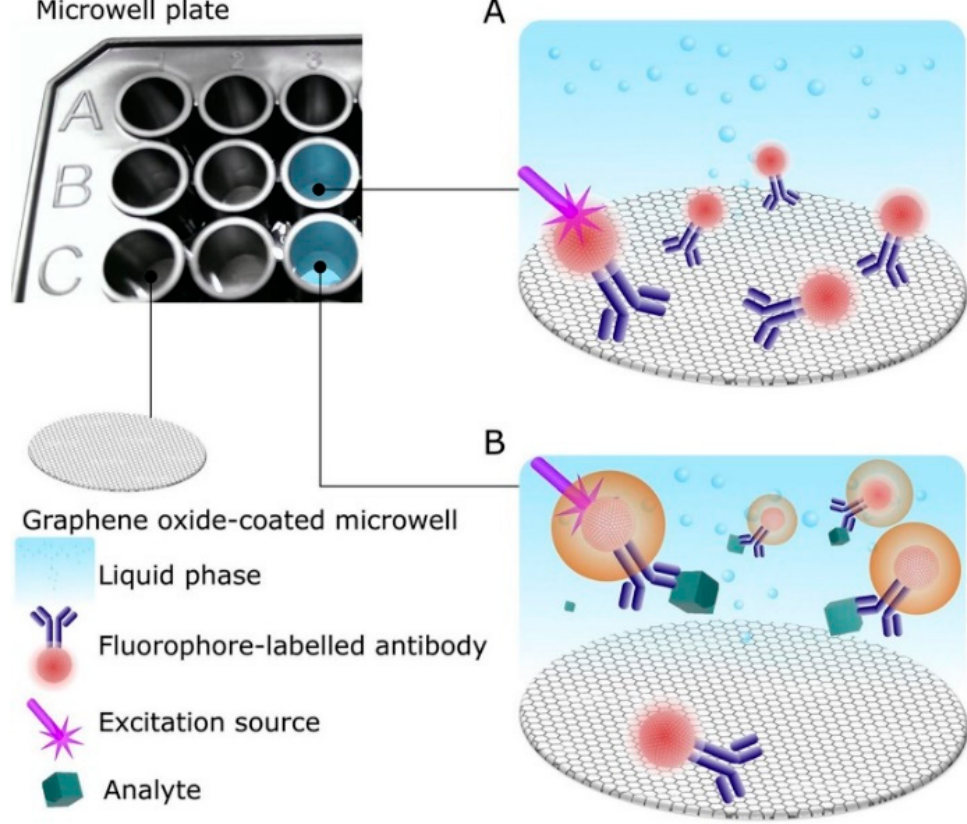
Figure 16. Optical immunosensor for prostate-specific antigen in urine. Fluorescent QDs-antibodies conjugates are quenched upon adsorption onto GO and immobilized onto a multi-well plate. Upon detection of the prostate-specific antigen, the resulting complex is formed and its affinity for GO decreases thereby increasing the fluorescence signal. Image adapted from [113] with permission of Elsevier, 2020.